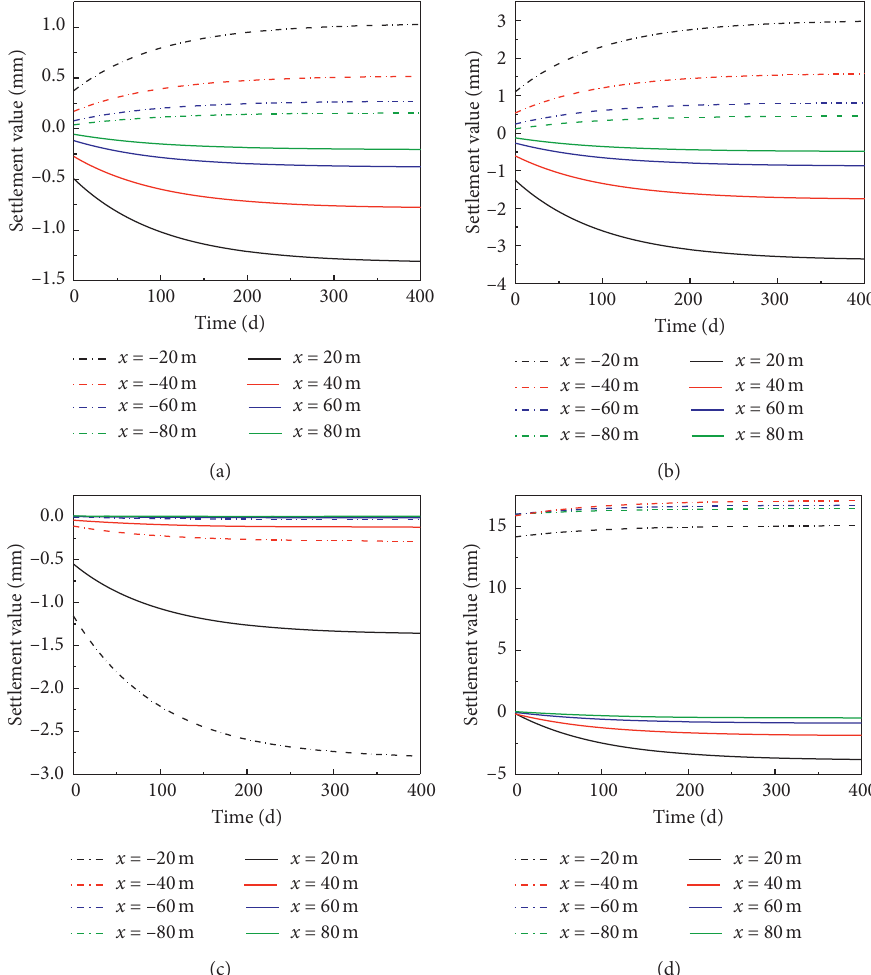
Figure 8: Different distances from the excavation face caused a change in the ground settlement with time under the action of the support pressures (a), shield shell frictions (b), grouting pressures (c), and total displacement over time